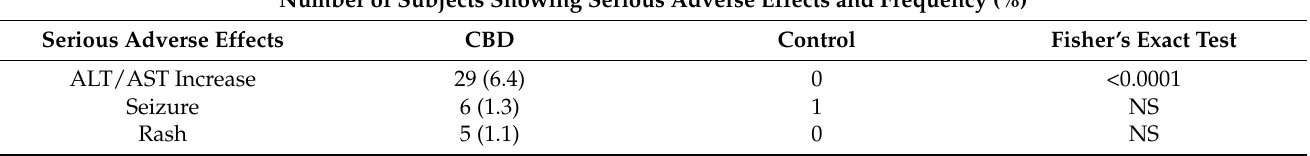
Table 3. The most common serious adverse effects reported in RCTs on CBD.